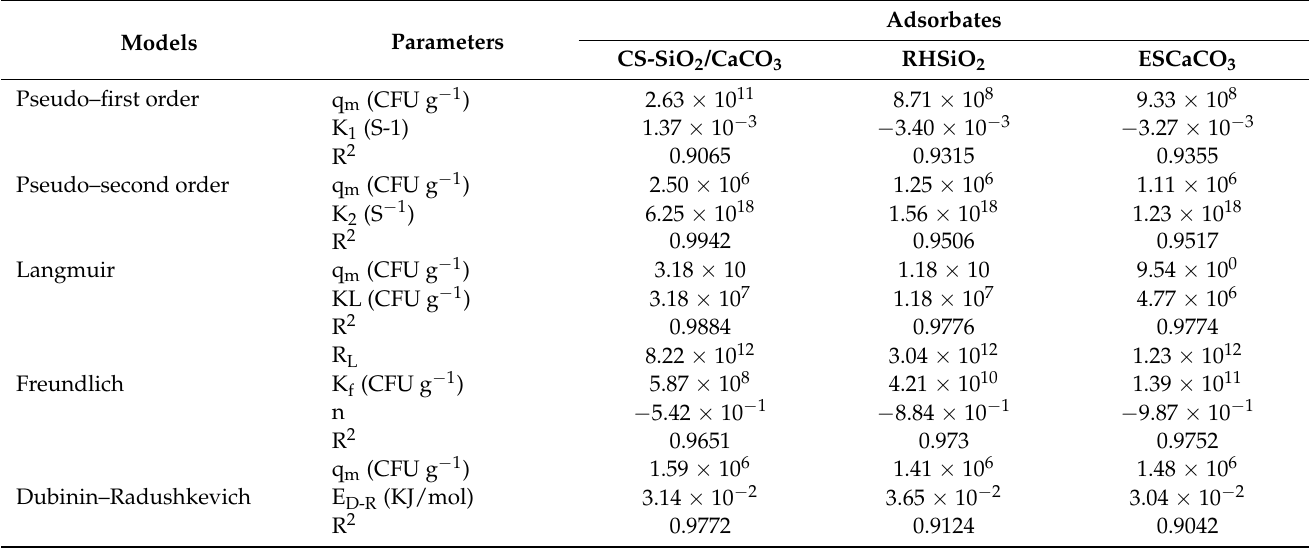
Figure 4. Comparison of adsorption of E. coli ( a ), the pseudo-first order and pseudo-second order kinetics of ESCaCO 3 NPs ( b ), RHSiO 2 NPs ( c ), and CS-SiO 2 /CaCO 3 NCs ( d ) respectively. Table 1. Parameters of pseudo–first order, pseudo–second order, Langmuir adsorption isotherm, Freundlich adsorption isotherm, and Dubinin–Radushkevich isotherm of CS-SiO 2 /CaCO 3 NCs, RHSiO 2 NPs, and ESCaCO 3 NPs